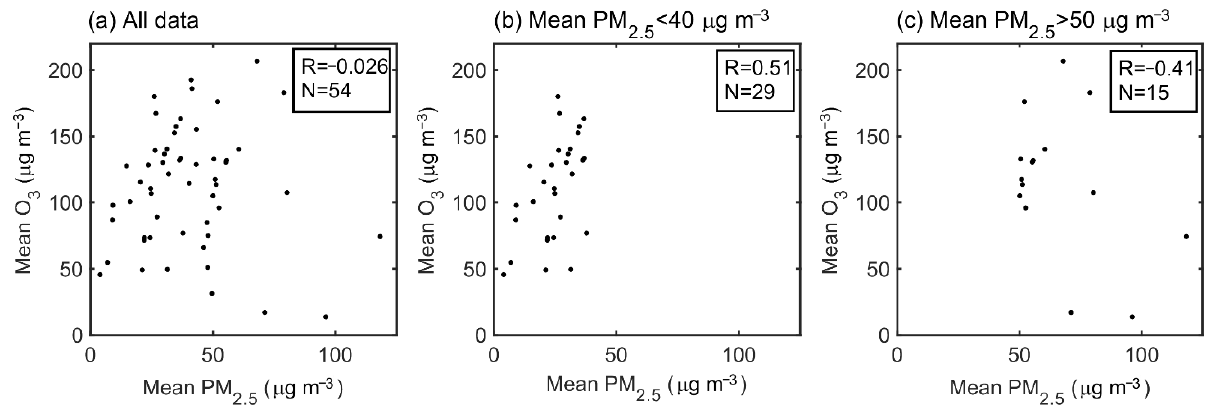
Figure 5. The correlation between daytime (08:00 to 18:00 LST) average PM 2.5 and ozone concentrations for: ( a ) all the 54 days; ( b ) the 29 days that the daytime average PM 2.5 < 40 µg m − 3 ; ( c ) the 15 days that the daytime average PM 2.5 > 50 µg m − 3 .